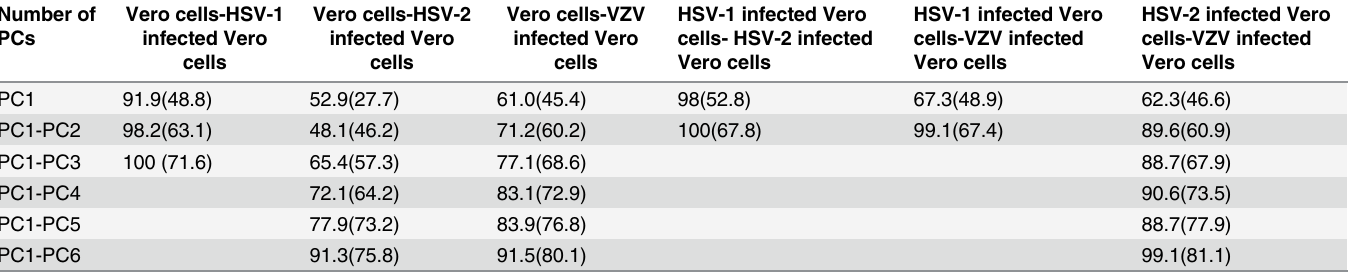
Table 3. Identification success in percentage versus PC number, derived using LDA calculation for six pairs. The cumulative variance is displayed in